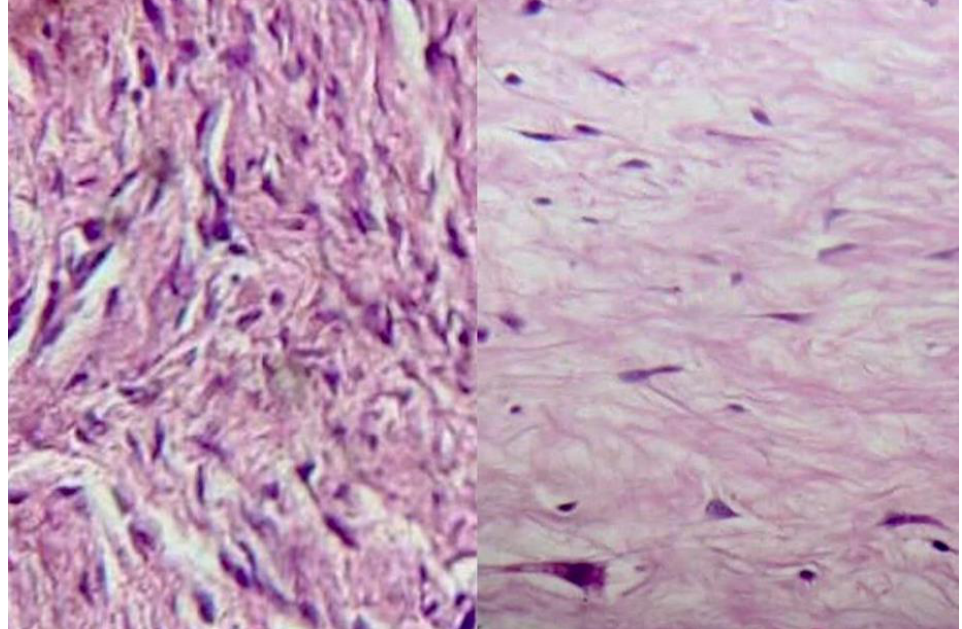
Fig. 3. Left, dense fibrous connective tissue stroma with round and spindle-shaped fibroblasts (200X). Right, loose myxoid fibrous connective tissue stroma. Round, stellate and spindle-shaped fibroblasts